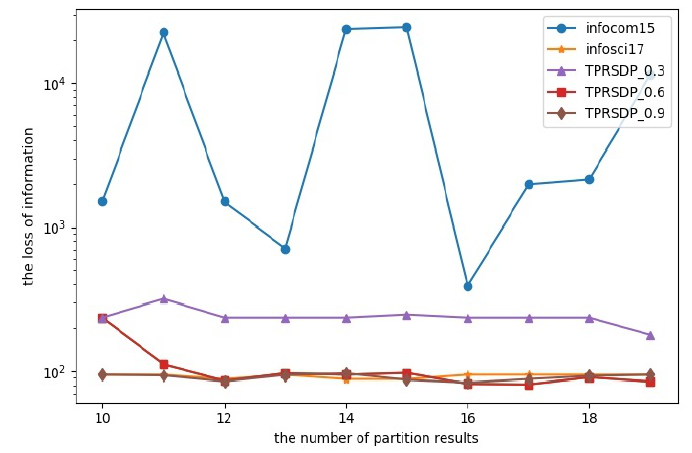
Figure 4. The loss of information(Geolife dataset).